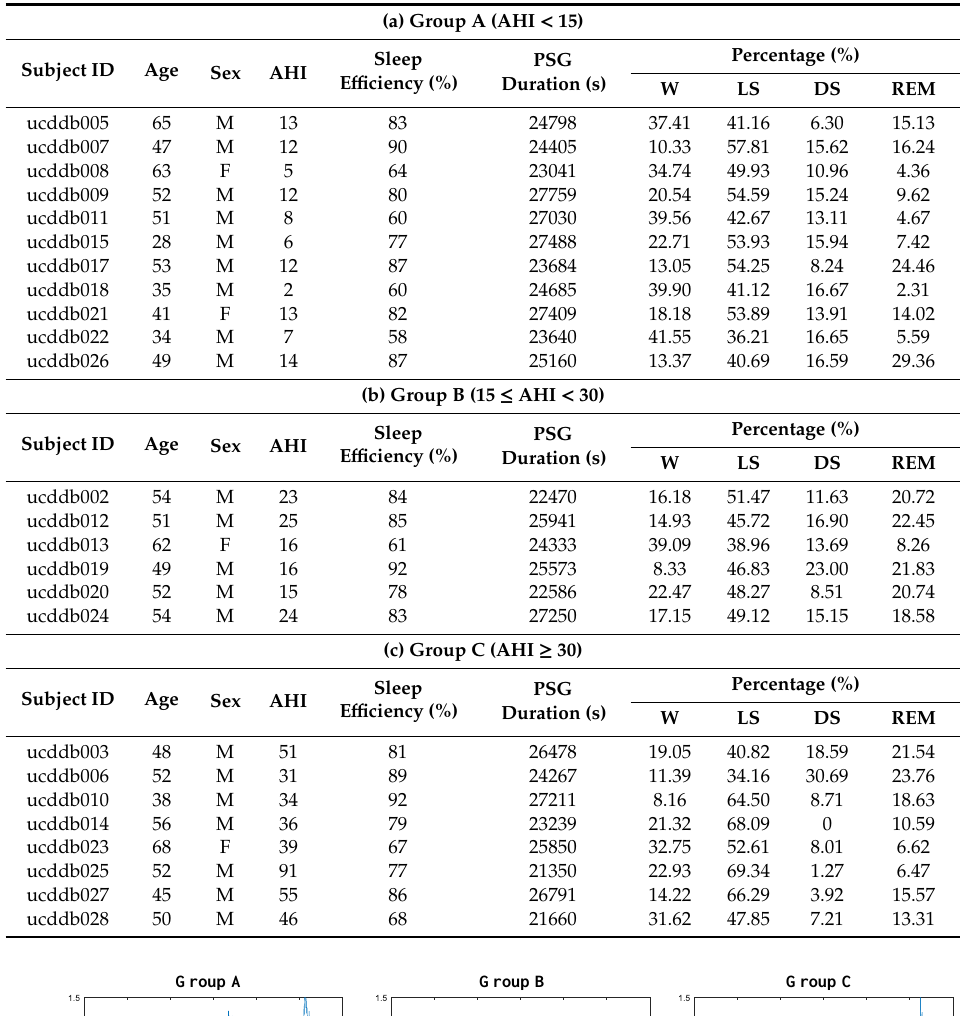
Table 1. Polysomnograms results of the grouped subjects in UCDDB database.